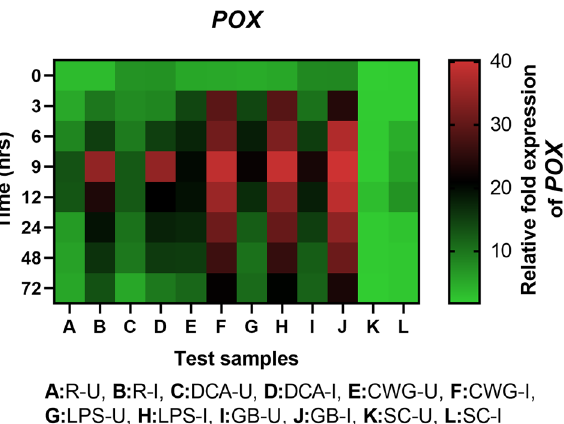
Figure 8. qRT-PCR determined relative expression of POX genes in 2-day-old P. glaucum seedlings with (I) or without (U) Sclerospora graminicola inoculation harvested 0, 3, 6, 9, 12, 24, 48, and 72 h. R—resistant, S— susceptible, DCA—3,5-Dichloroanthranilic acid treated, CWG—Cell Wall Glucans isolated from the endophyte Trichoderma hamatum UOM 13, LPS—Lipopolysaccharides isolated from bacteria Pseudomonas fluorescens UOM 14, GB—Glycinebetaine an amino acid derivative. Expression levels were measured by qPCR and normalized to the constitutive PP2A gene. Values are means of experiments carried out in four replicates. The bars indicate ± SE and the data were analyzed by one-way ANOVA followed by Tukey’s test and p ≤